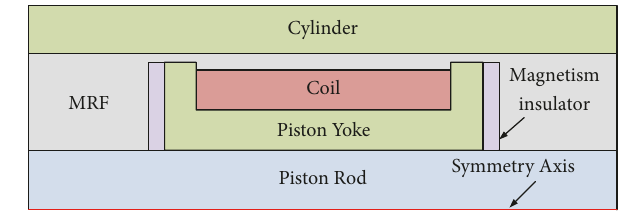
Figure 11: 2D axisymmetric geometric model of MRF damper with